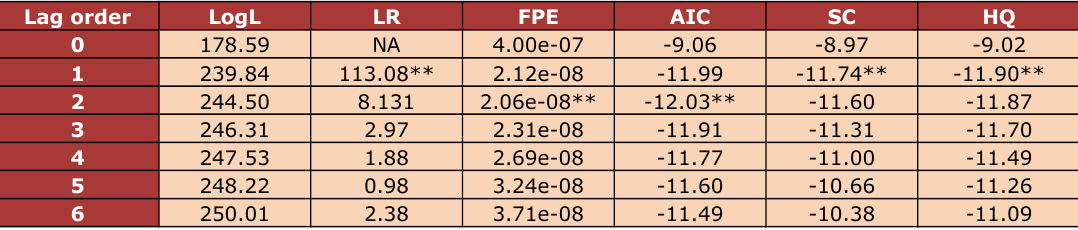
Table 3. Test table of VAR lag model order